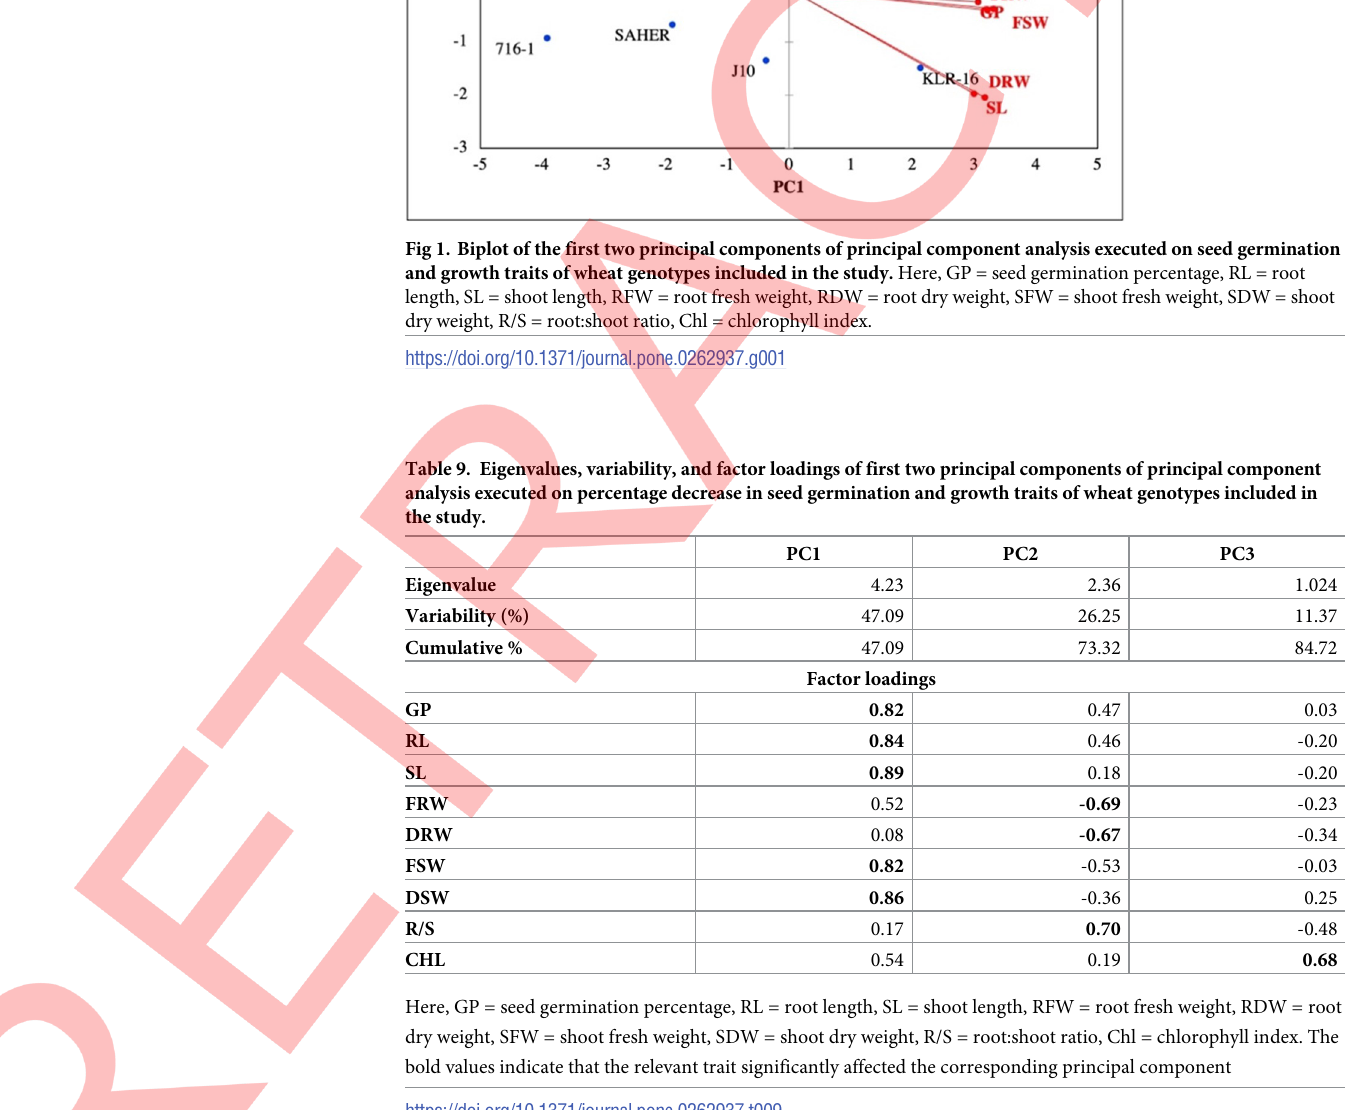
Here, GP = seed germination percentage, RL = root length, SL = shoot length, RFW = root fresh weight, RDW = root dry weight, SFW = shoot fresh weight, SDW = shoot dry weight, R/S = root:shoot ratio, Chl = chlorophyll index. The bold values indicate that the relevant trait significantly affected the corresponding principal